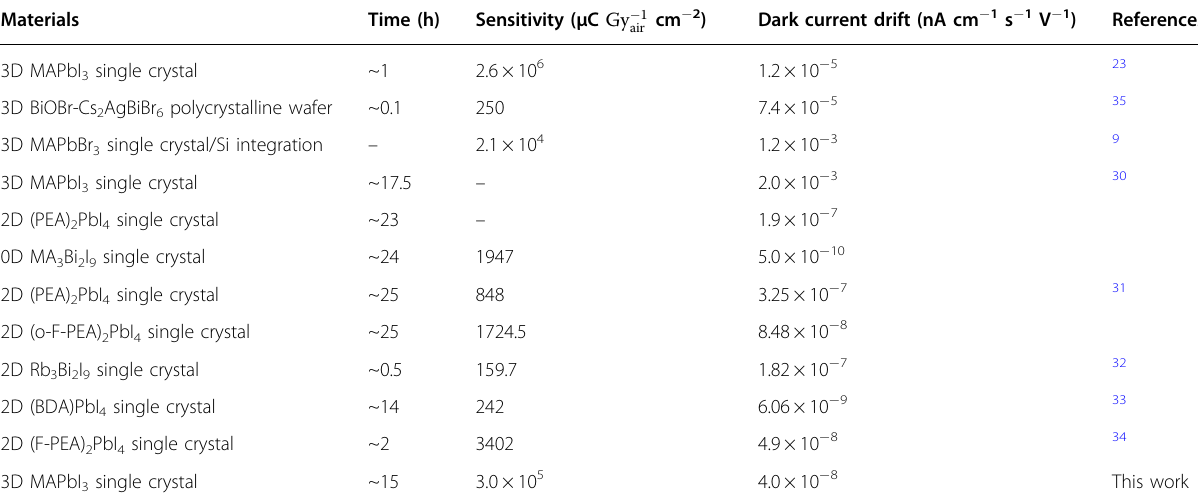
Table 1 Dark current drift for part of the reported perovskite-based X-ray or γ -ray detectors